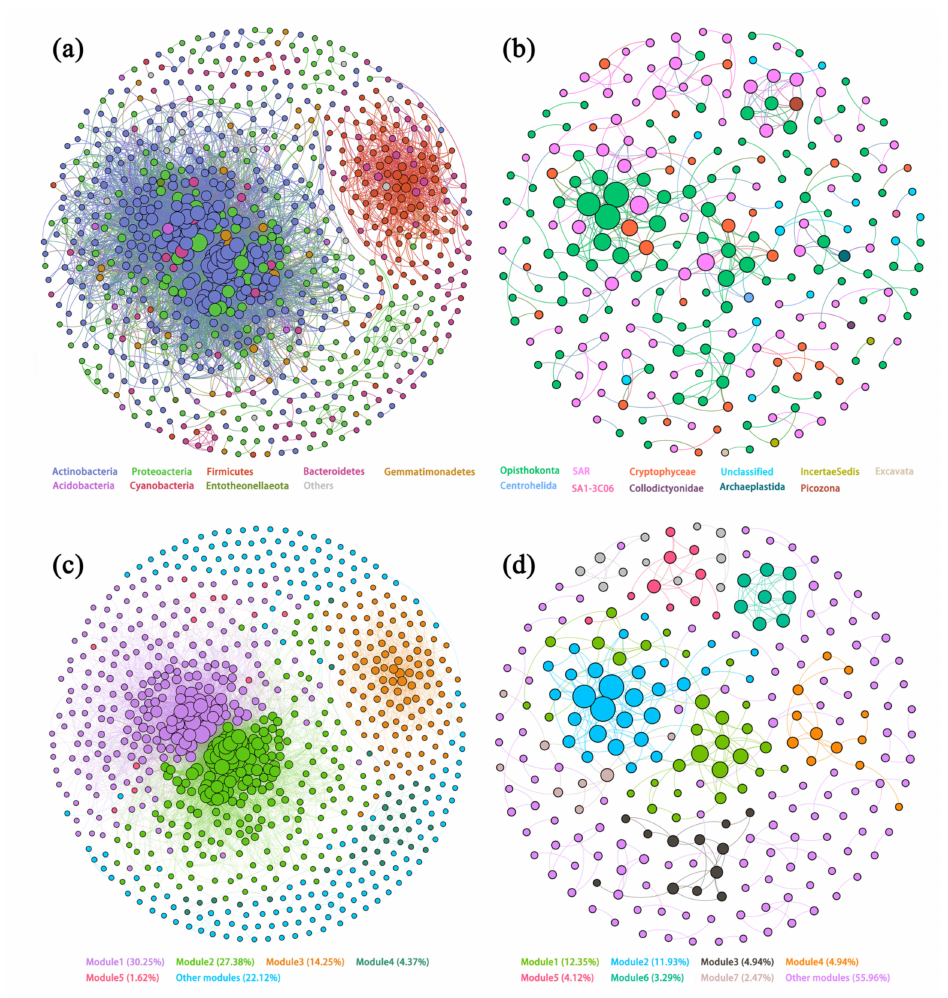
Figure 4. The co-occurrence network patterns among the OTUs of bacteria ( a , c ) and microeukaryotes ( b , d ) colored by taxonomic group ( a , b ) and modules ( c , d